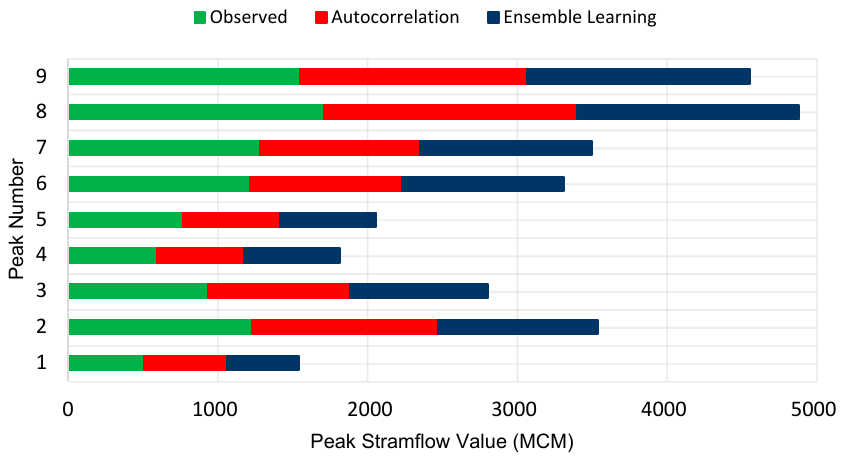
Figure 8. Comparison of peak samples.